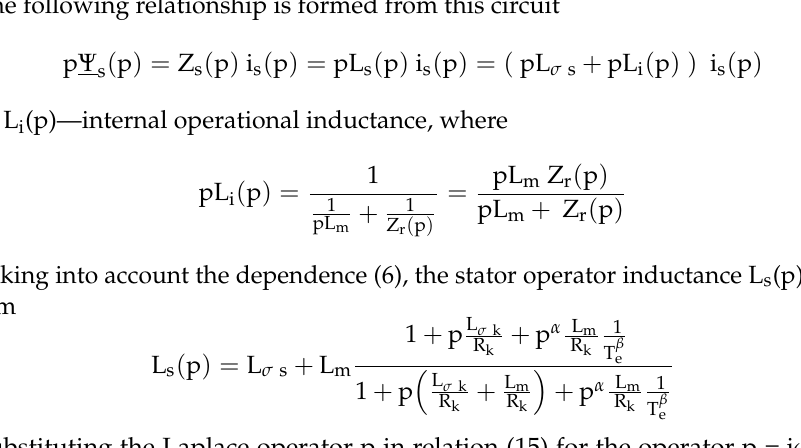
Figure 3. Equivalent circuit of the stator operational inductance L s (p).